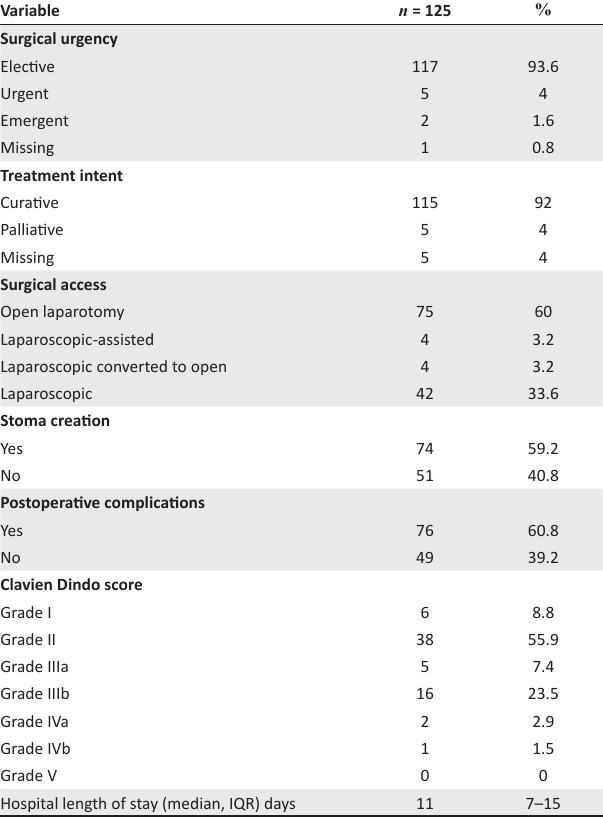
TABLE 3: Surgical information for the study cohort ( n = 125).